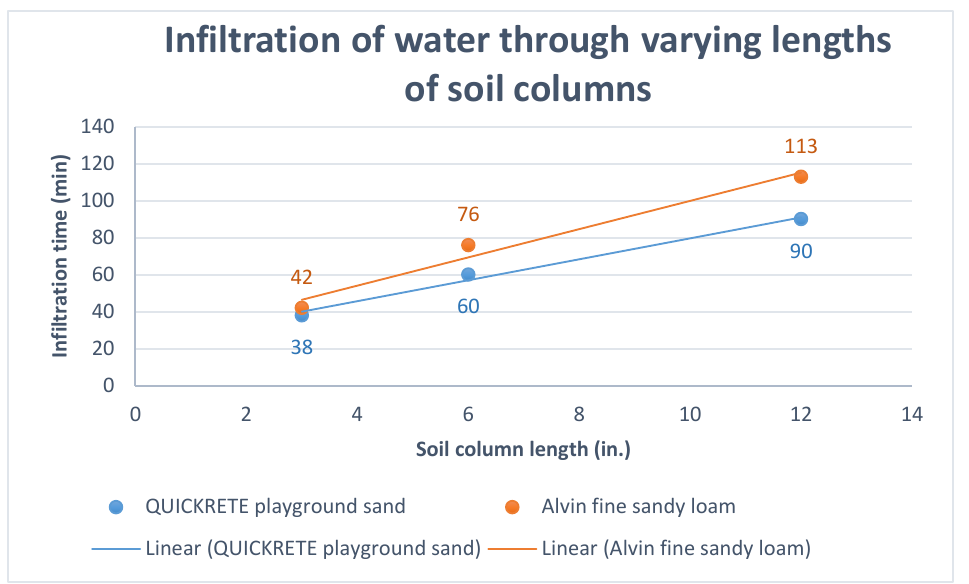
Figure 9. The infiltration time of water through 3, 6, and 12 inches of soils Alvin fine sandy loam and QUICKRETE playground sand.